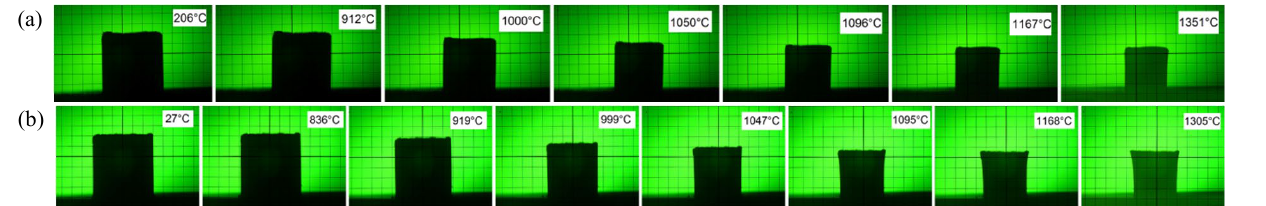
Fig. 2 Heating microscope images of green varistor samples: (a) basic composition, (b) basic composition with 0.5 wt% of AlF 3 –CaB 4 O 7 sintering